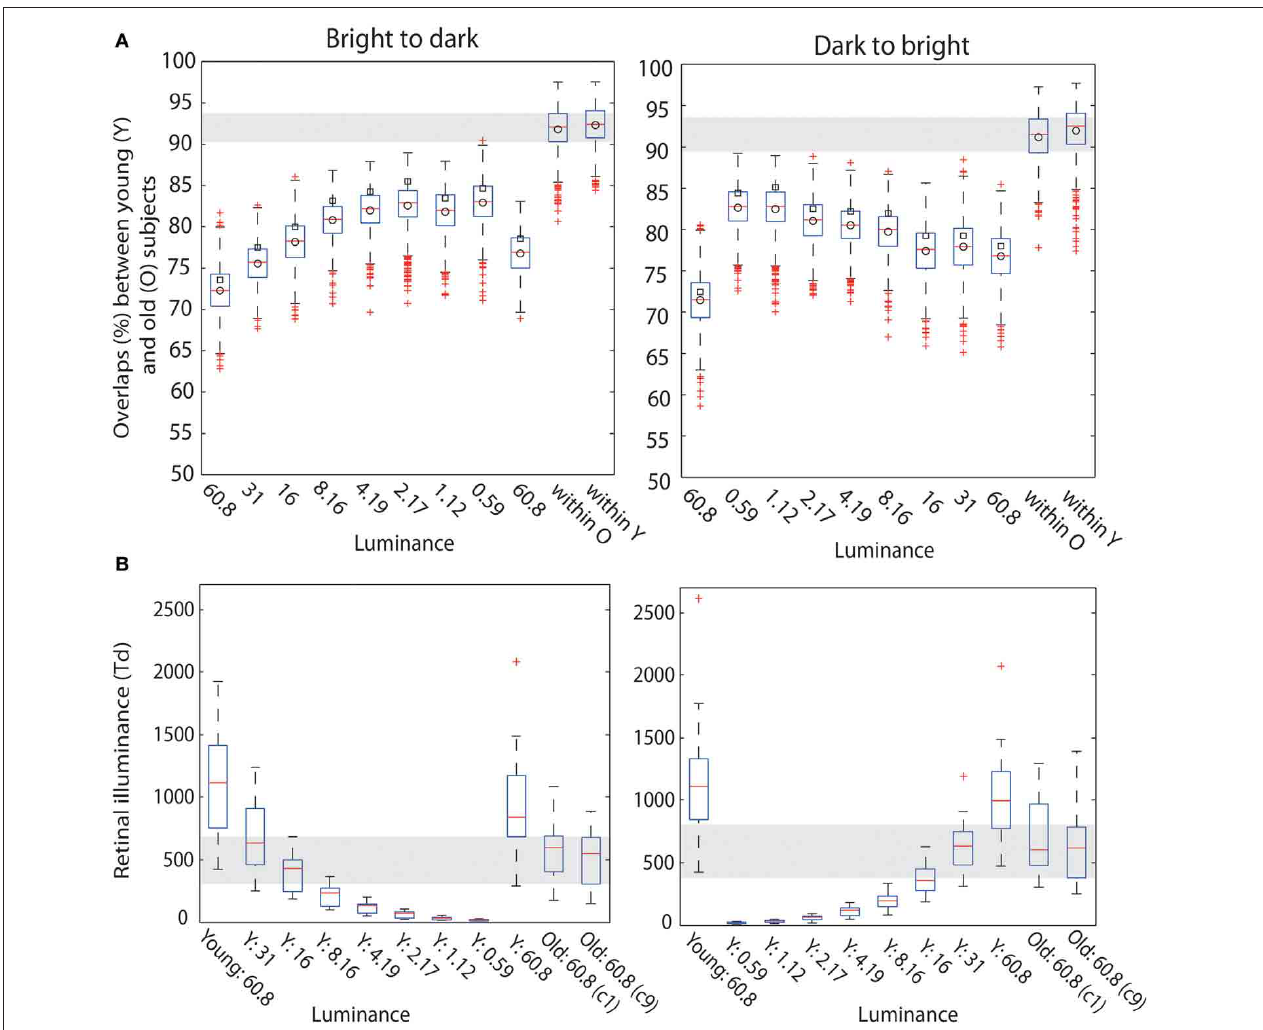
yielded by our calculation; the circle is the mean of the bootstrapped overlaps—thus, the difference between the values for circle and square suggests that our estimation of the overlap is positively biased. (B) Retinal illuminance of young and old subjects. The first nine boxplots in each subplot depict the distributions of retinal illuminances in young subjects, at nine luminances; the two last boxplots in each subplot show results in old subjects in the two brightest conditions (luminance = 60.8cd/m 2